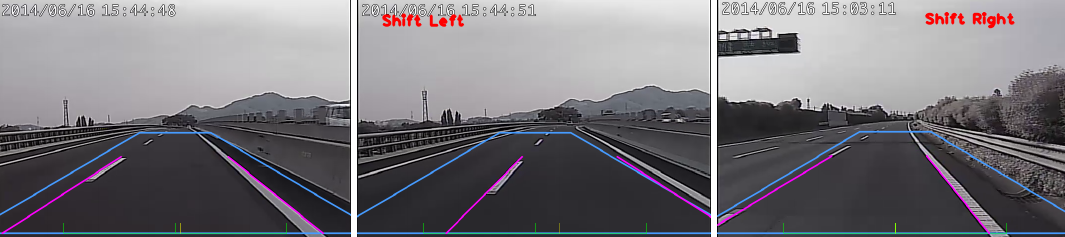
Figure 2. The illustration of lane departure status. Left : normal. Middle : shift left. Right : shift right. In the images, a trapezoid region is set as the region of interest (ROI) for line detection.